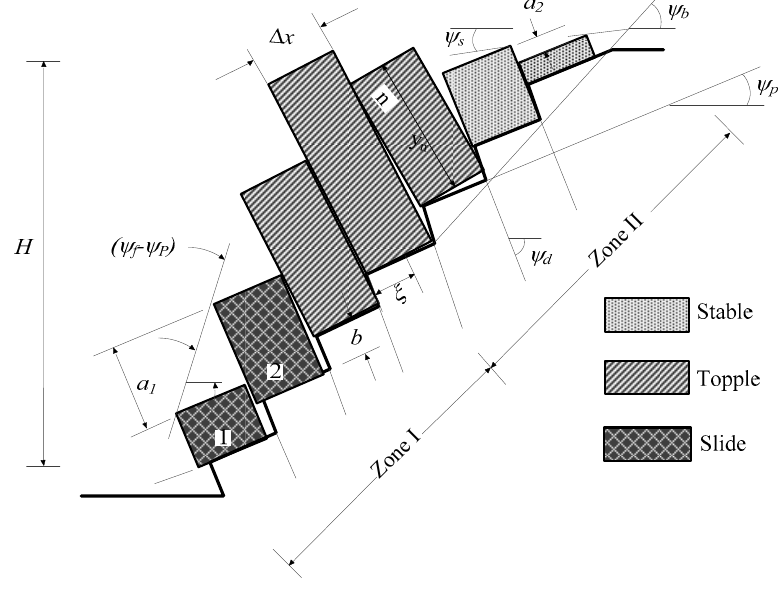
Figure 2. The geometric model of a toppling slope (modified based on [22] after [8]).